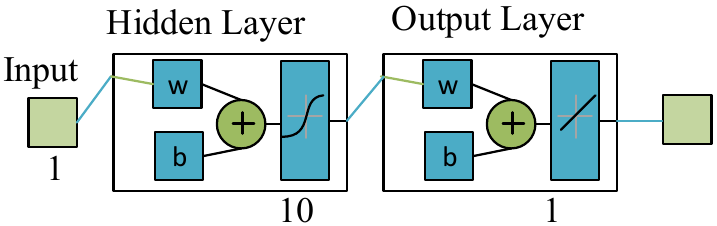
Figure 7. ANN training Algorithm.